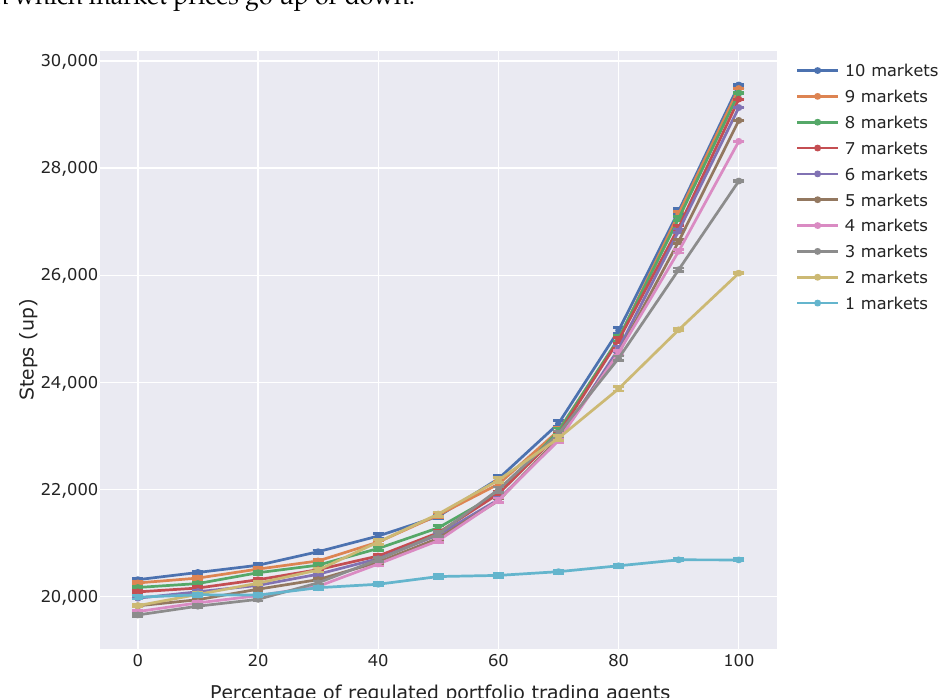
Figure 11. Steps in which the market prices went up. The horizontal axis is the percentage of regulated portfolio trading agents among all non-regulated and regulated portfolio trading agents. The vertical axis is the mean number of Steps in which the market prices went up. Each series of plots shows results for a certain number of markets in the simulation. Error bars show standard